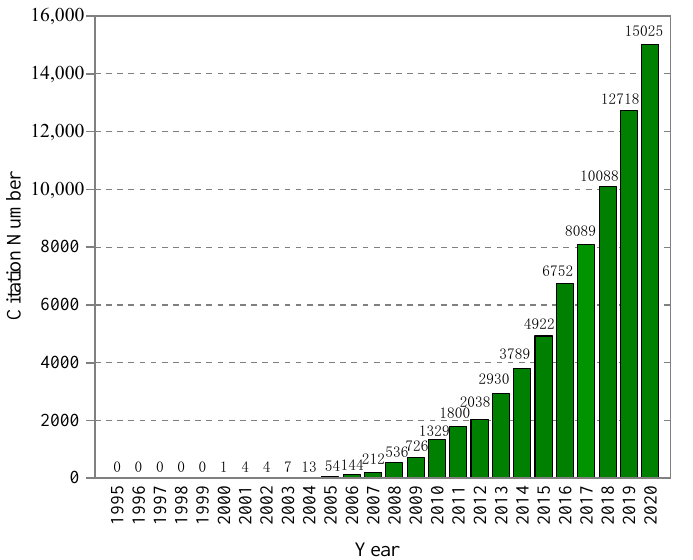
Figure 2. Distribution of citations per year on MFCs in wastewater treatment from 1995 to 2020.